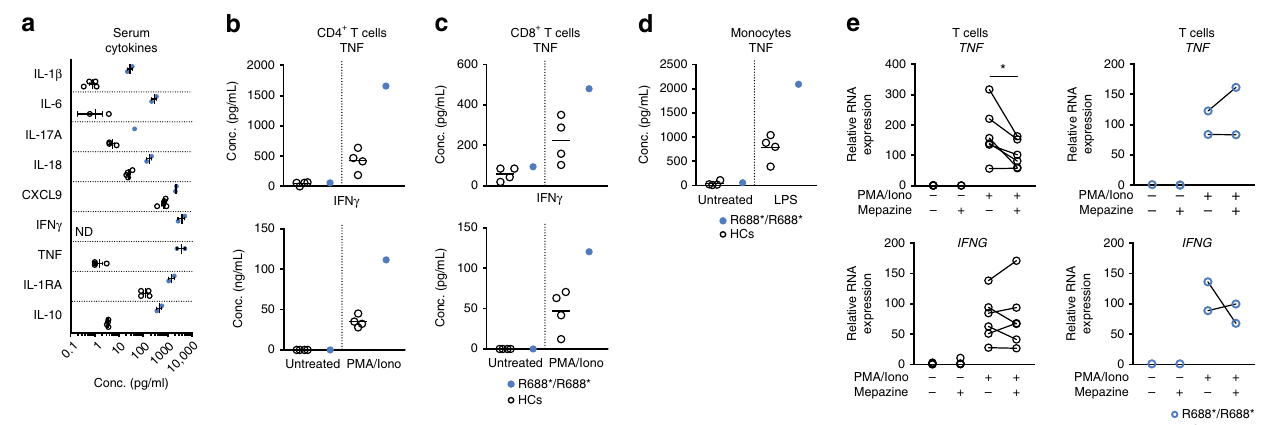
Fig. 3 T cells and monocytes contribute to hypercytokinemia in the R688*/R688* proband. a Serum concentration of the cytokines IL-1 β , IL-1RA, IL-6, IL-10, IL-17A, IL-18, IFN γ , CXCL9, and TNF in HCs ( n = 4) and proband (two biological replicates) or HCs ( n = 3) and proband (one biological replicate) in the case of the cytokine IL-17A. Mean and SEM are depicted. b , c ELISA of TNF and IFN γ produced by in vitro PMA/ionomycin stimulated CD4 + T cells ( b ) or CD8 + T cells ( c ) of HCs ( n = 4) and proband. d ELISA of TNF produced by monocytes of HCs ( N = 4) or proband treated in vitro overnight with LPS. e RT- qPCR quantifying TNF and IFNG transcripts in PMA/ionomycin stimulated T cells in absence or presence of mepazine pretreatment (20 ′ ). Cells were sampled 1 h after stimulation. Data was normalized using the housekeeping genes HPRT and GAPDH . HCs ( n = 6). * p < 0.05 (paired t -test). R688* proband ( n = 2). Data shown are accumulated from two independent experiments ( a , e ) or representative for two independent experiments ( b – d ). Source data are provided as a Source Data fi T cells (Supplementary Fig. 3C). To study the effects of truncated R688* Roquin-1 on mRNA transcripts of TNF and IFNG in more detail, we stimulated R688* or HC T cells with or without pretreatment of the cells with mepazine (Fig. 3e). Mepazine inhibits Roquin-1 degradation upon T cell activation (Supple- mentary Fig. 1K) and promotes Roquin-1 dependent mRNA regulation. Con fi rming the impaired function of R688* Roquin-1, TNF mRNA was not reduced in the setting of stimulated R688*/ R688* T cells pretreated with mepazine (Fig. 3e). In contrast,